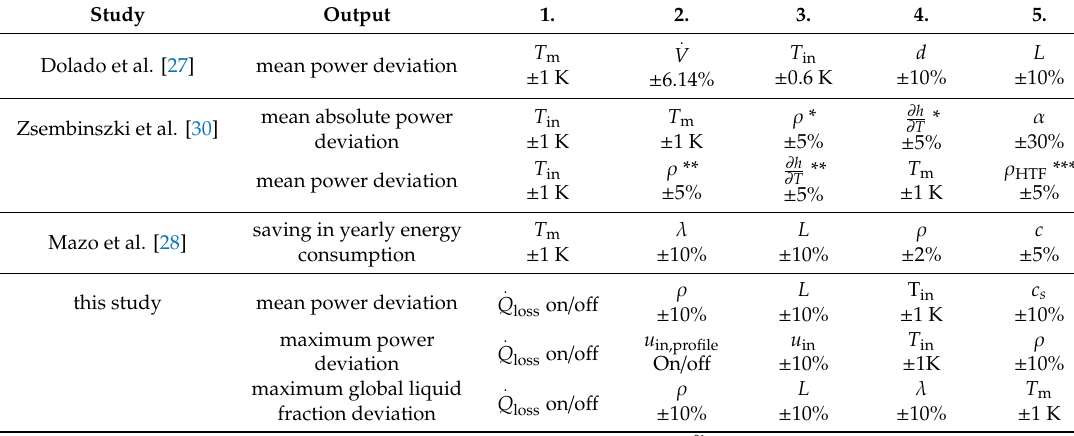
Table 5. Comparison of the most influential parameters and their assumed